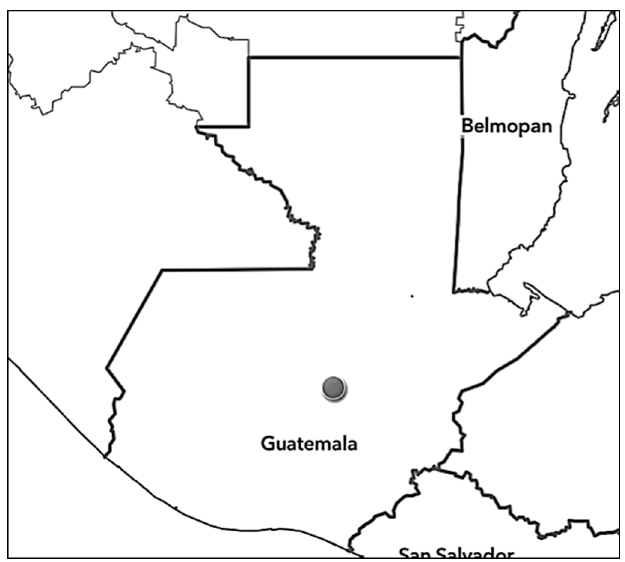
Figure 8. The approximate location where Schiedeella bajaverapacensis was found.